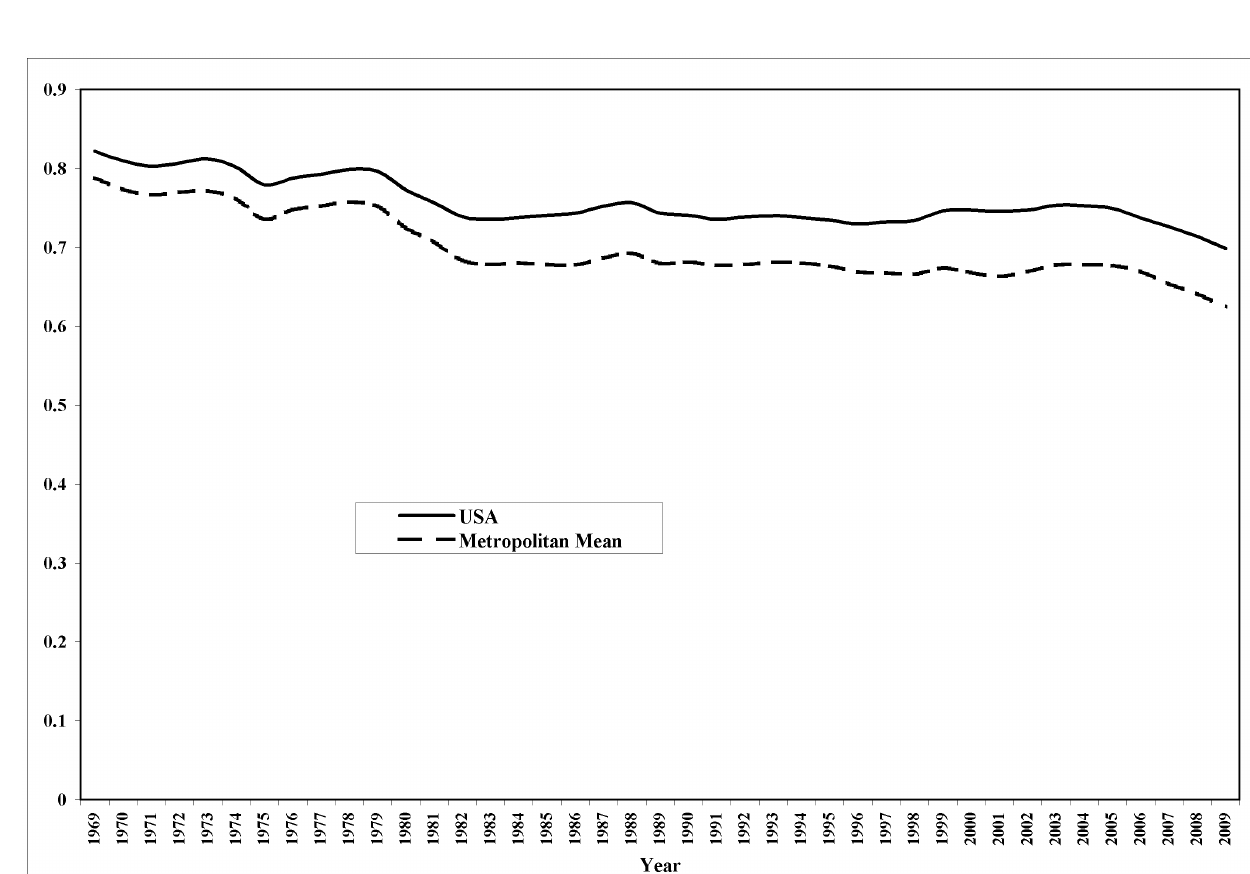
Figure 3. Ratio of urban labor income to total income ( 1– a ) for MSAs and Micropolitan Areas in the U.S. 1969–2009.